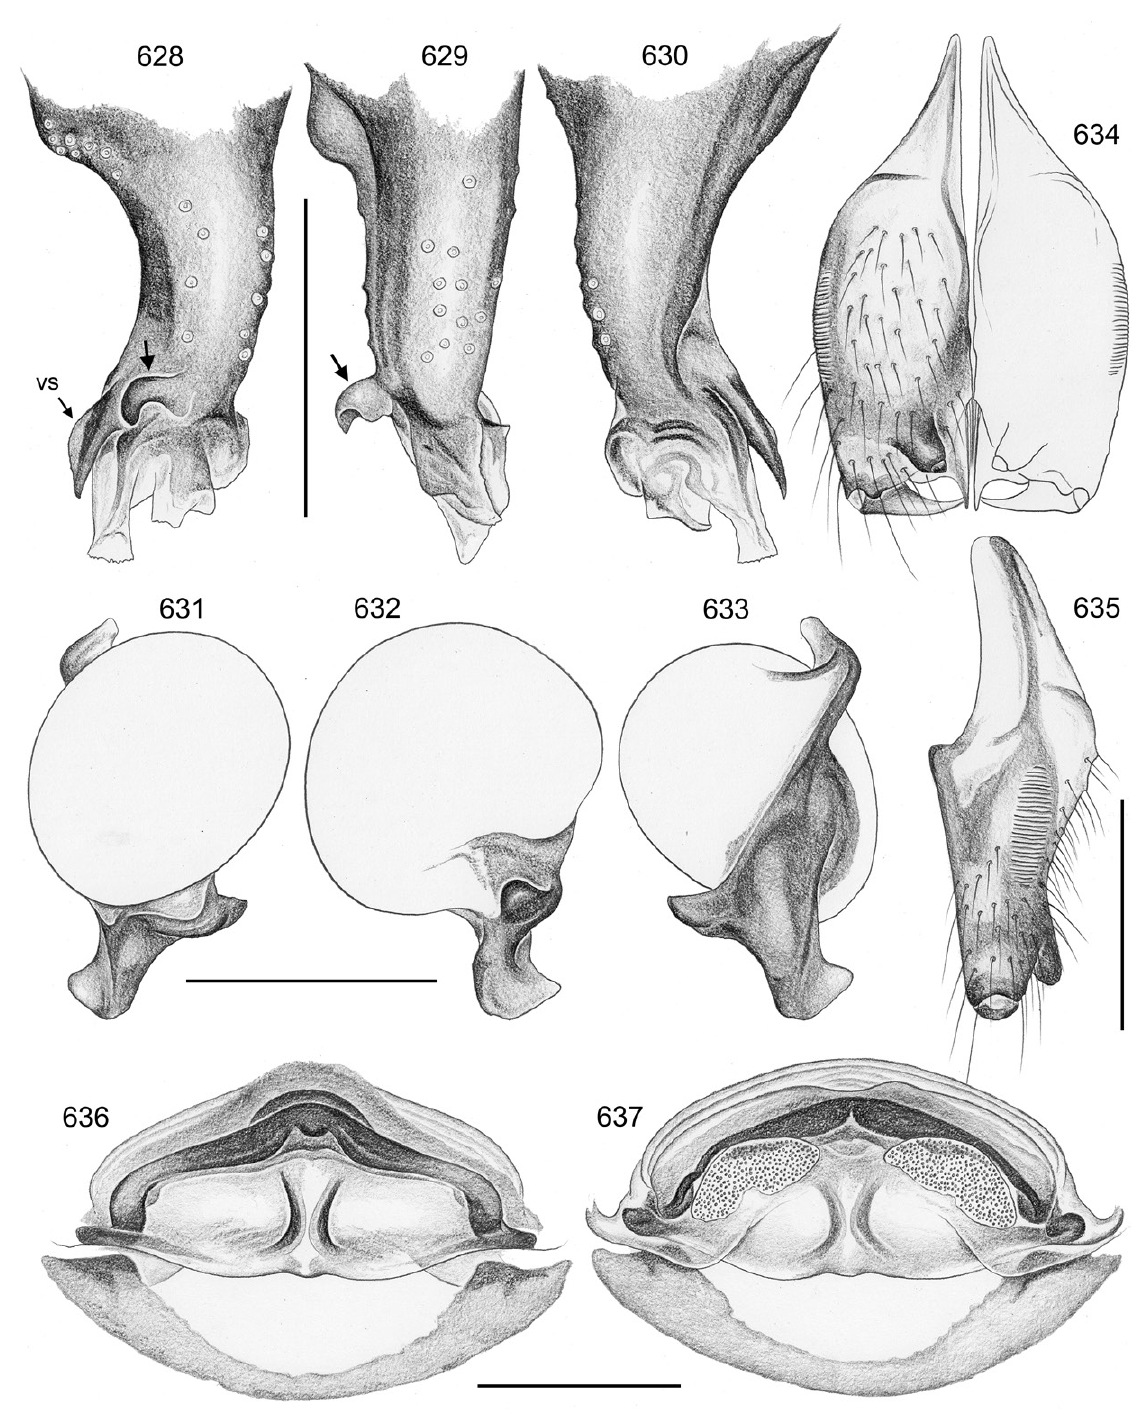
Figs 628–637. Crossopriza manakhah sp. nov.; male from Yemen, 12 km NW of Manakhah (ZFMK Ar 22441), female from Yemen, Ja‘ar (ZFMK Ar 22444). 628–630 . Left procursus, prolateral, dorsal, and retrolateral views; arrows: distinctive prolateral process. 631–633 . Left genital bulb, prolateral, dorsal, and retrolateral views. 634–635 . Male chelicerae, frontal and lateral views. 636–637 . Cleared female genitalia, ventral and dorsal views. Abbreviation: vs = ventral sclerite. Scale bars = 0.3